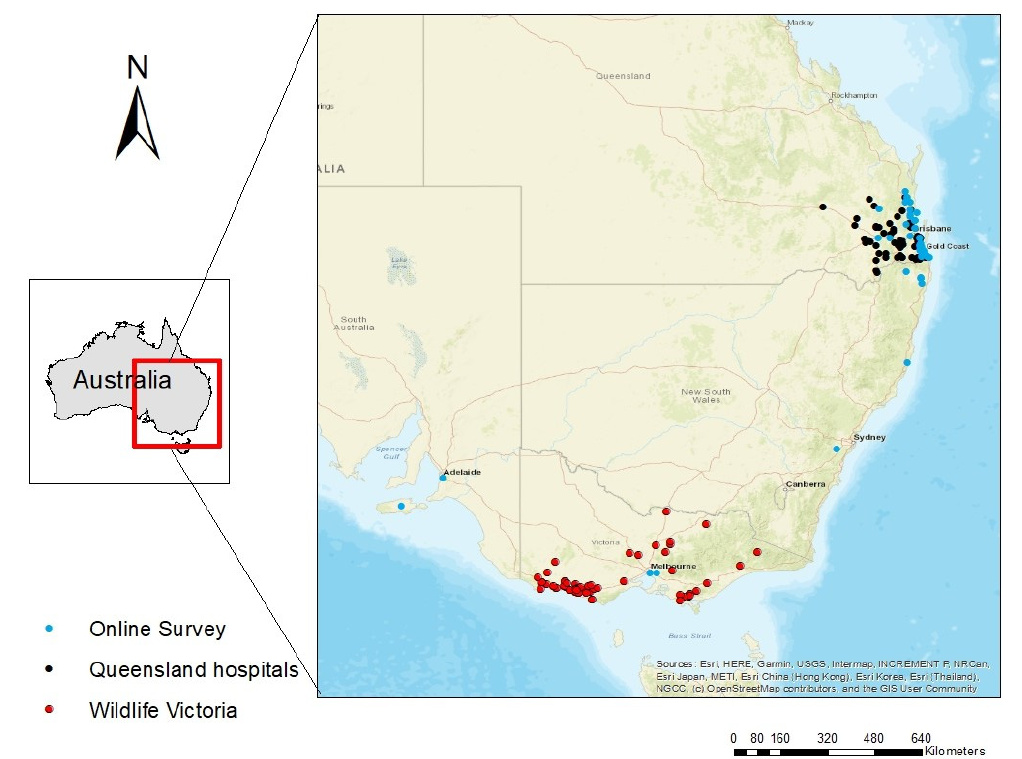
Figure 1. The locations of livestock-related incidents to koalas which were reported by Queensland hospitals, Wildlife Victoria and online survey respondents.